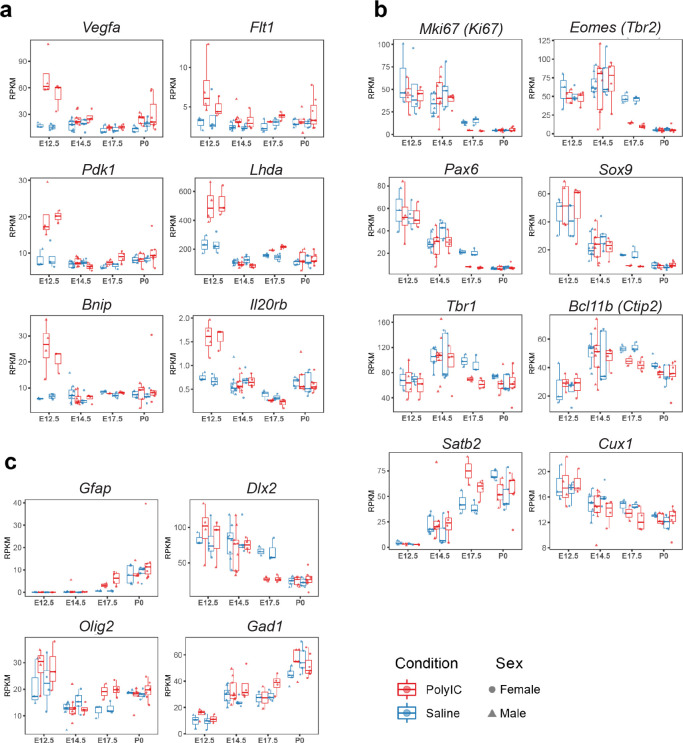
Sex-stratified RPKM gene trajectories of genes presented in the manuscript showing concordant effects between males and females.(a) Vegfa, Flt1, Pdk1, Ldha, Bnip3, Il20rb. (b) Mki67, Eomes, Pax6, Sox9, Tbr1, Bcl11b, Satb2, Cux1. (c) Gfap, Dlx2, Olig2, Gad1.